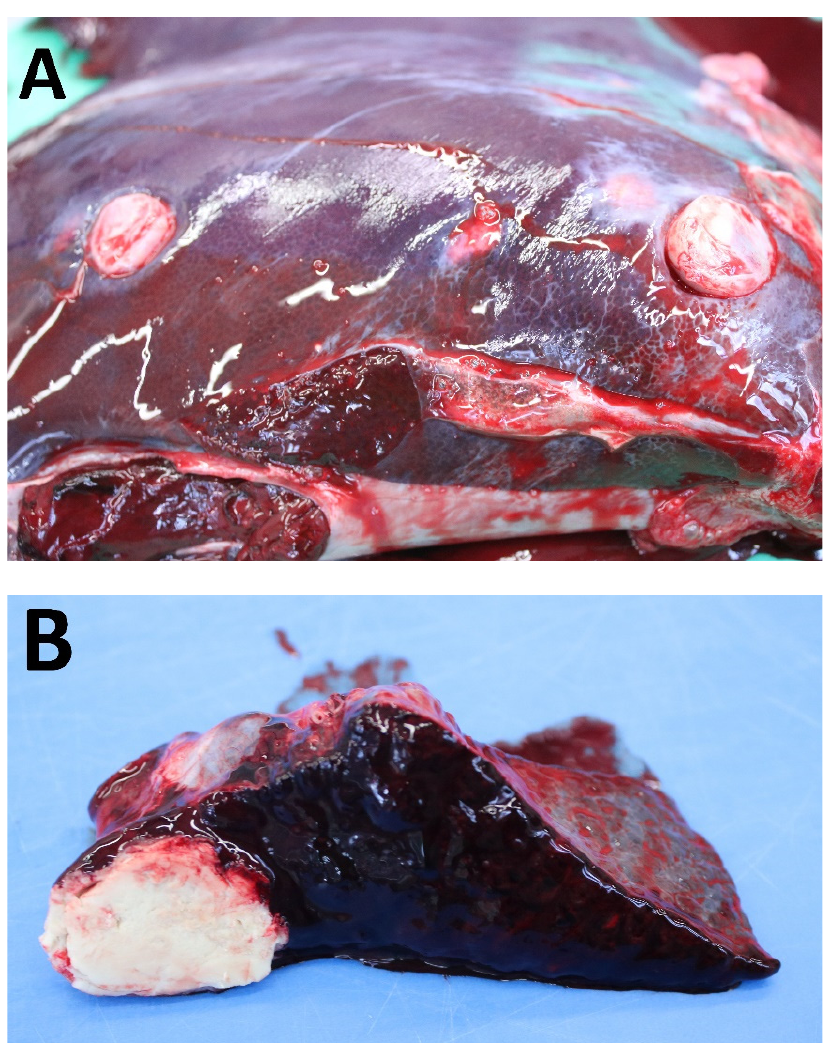
Figure 3. Abscesses in the liver ( A ) and the spleen ( B ) of stallion S1. The abscesses were caused by C. pseudotuberculosis and detected during post-mortem examination.